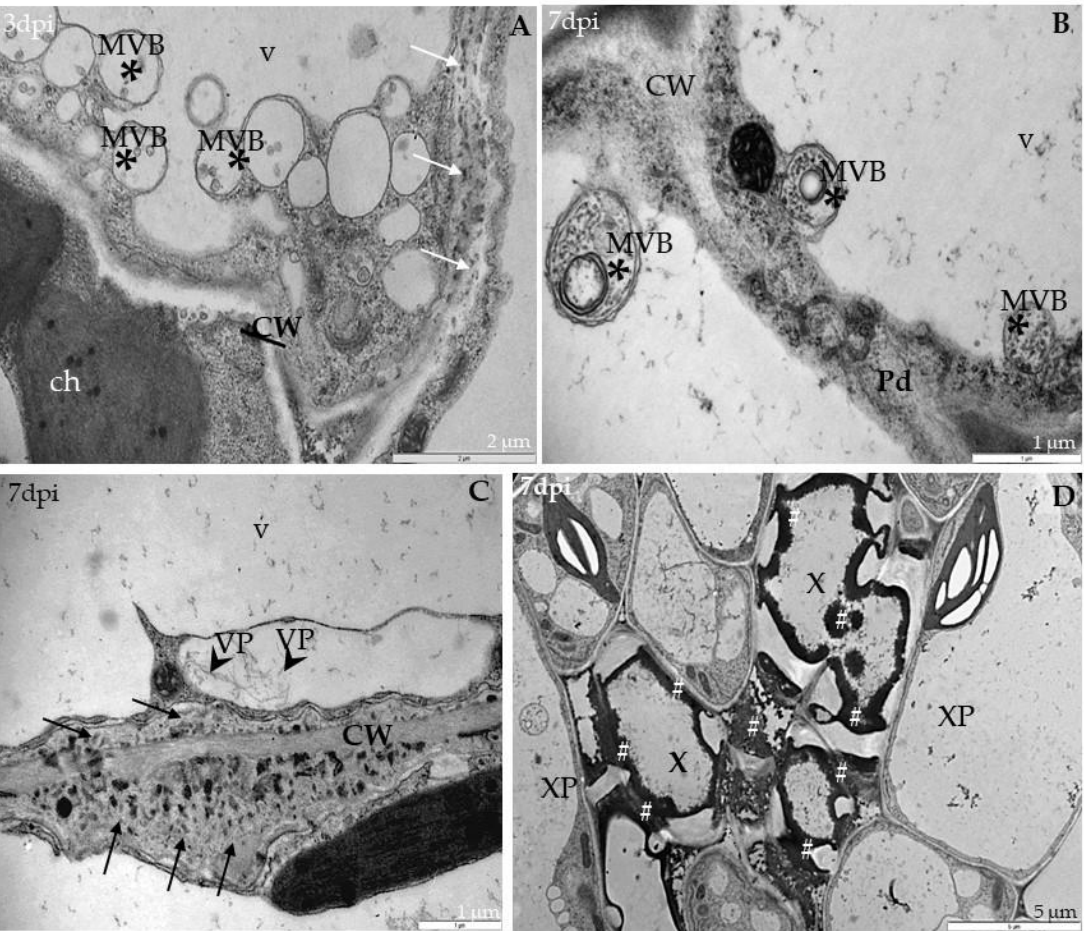
Figure 5. Multivesicular bodies’ induction, viral particles in vacuole and cell wall rebuilding in rbohD/F plants tissues 3 ( A ) and 7 days ( B – D ) after TuMV inoculation examined under a TEM. ( A ) Cell wall rebuilding (CW; arrows) and multivesicular bodies (MVB; *) in phloem parenchyma cells. Ch—chloroplast; V—vacuole. ( B ) Multivesicular bodies (MVBs; *) near plasmodesmata (Pd) in phloem parenchyma cells. CW—cell wall; V—vacuole. ( C ) Cell wall (CW) rebuilding (arrows) and virus particles (VPs; arrowhead) in membranous structures such as small vacuoles in palisade mesophyll cells. V—vacuole. ( D ) Accumulation of phenolic-like compounds (marked with #) inside xylem tracheary elements (X). XP—xylem parenchyma.